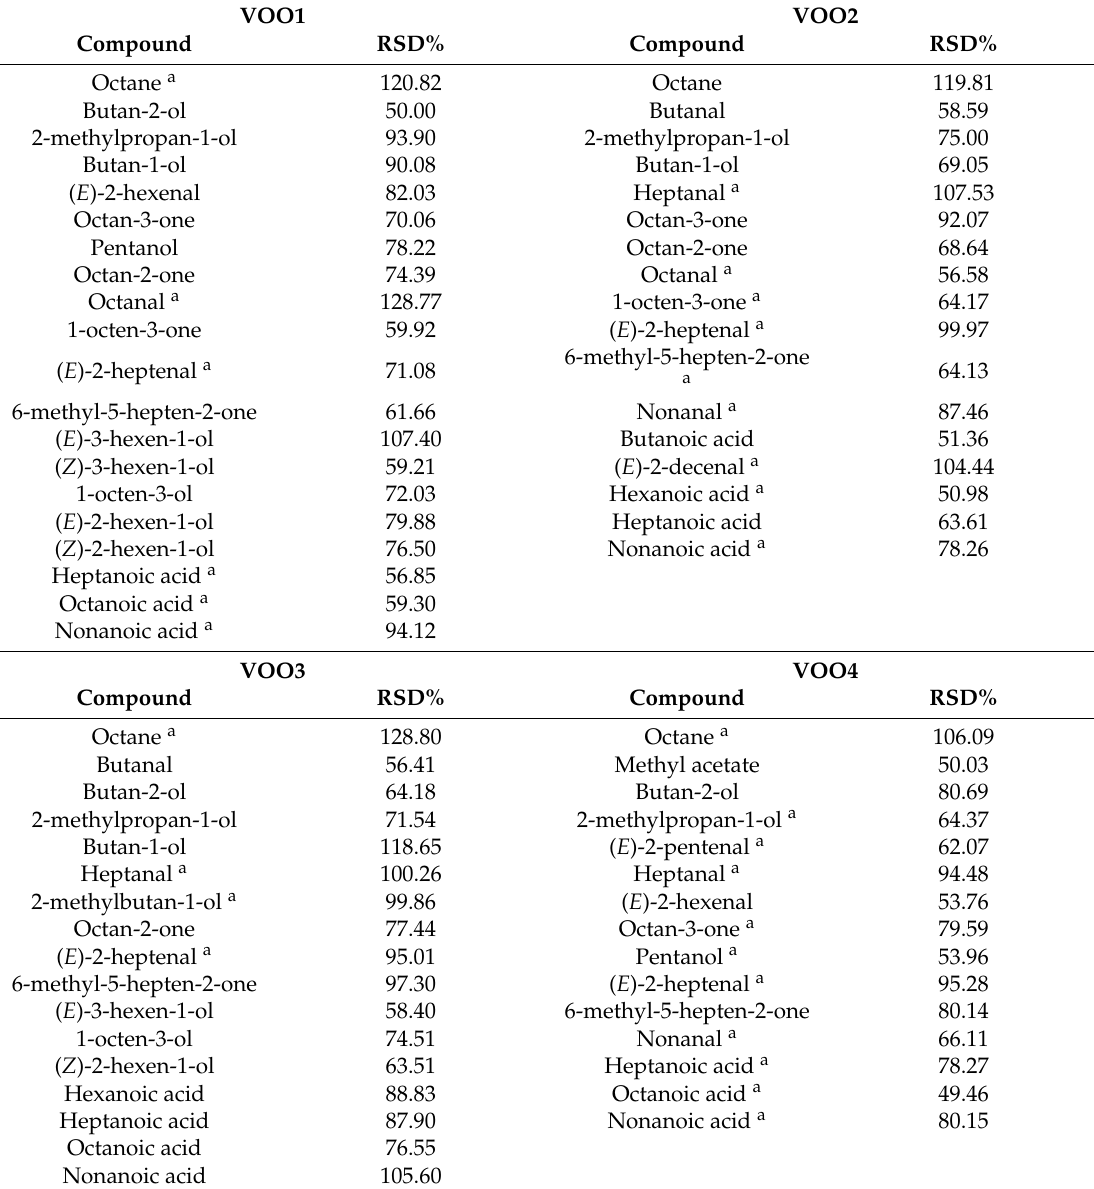
Table 3. Selected volatile compounds that showed statistically significant changes ( p -value < 0.05) and RSD% higher than 50% during the storage at moderate